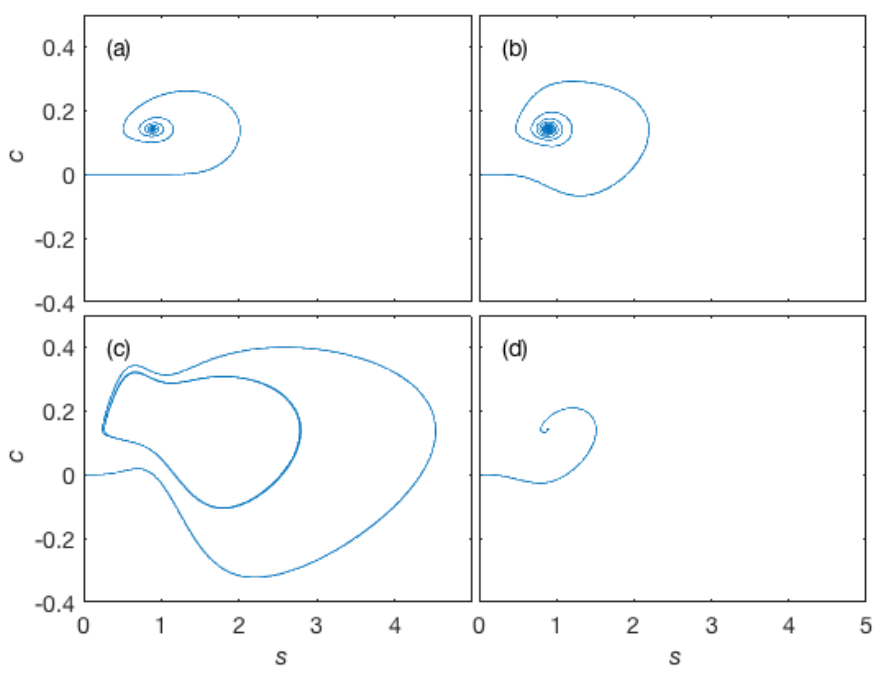
Figure 5. Trajectories of ( a ) the three-variable model and of ( b ) the m = 1, ( c ) m = 2 and ( d ) m = 3 reduced models for the same parameters as Figure 4. All trajectories were started from initial conditions near the origin, s ( 0 ) = 0.02, c ( 0 ) = 0. For the three-variable model, e ( 0 ) = 0 and the initial function was s ( θ ) = 0 for θ < 0 (i.e. there is a small discontinuity in the initial function at θ = 0).